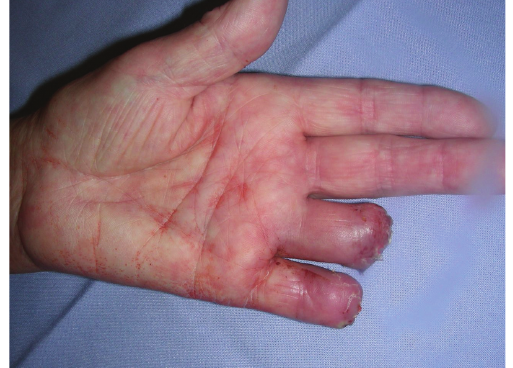
Figure 5: Amputated fingers after suture removal 2 weeks postop-